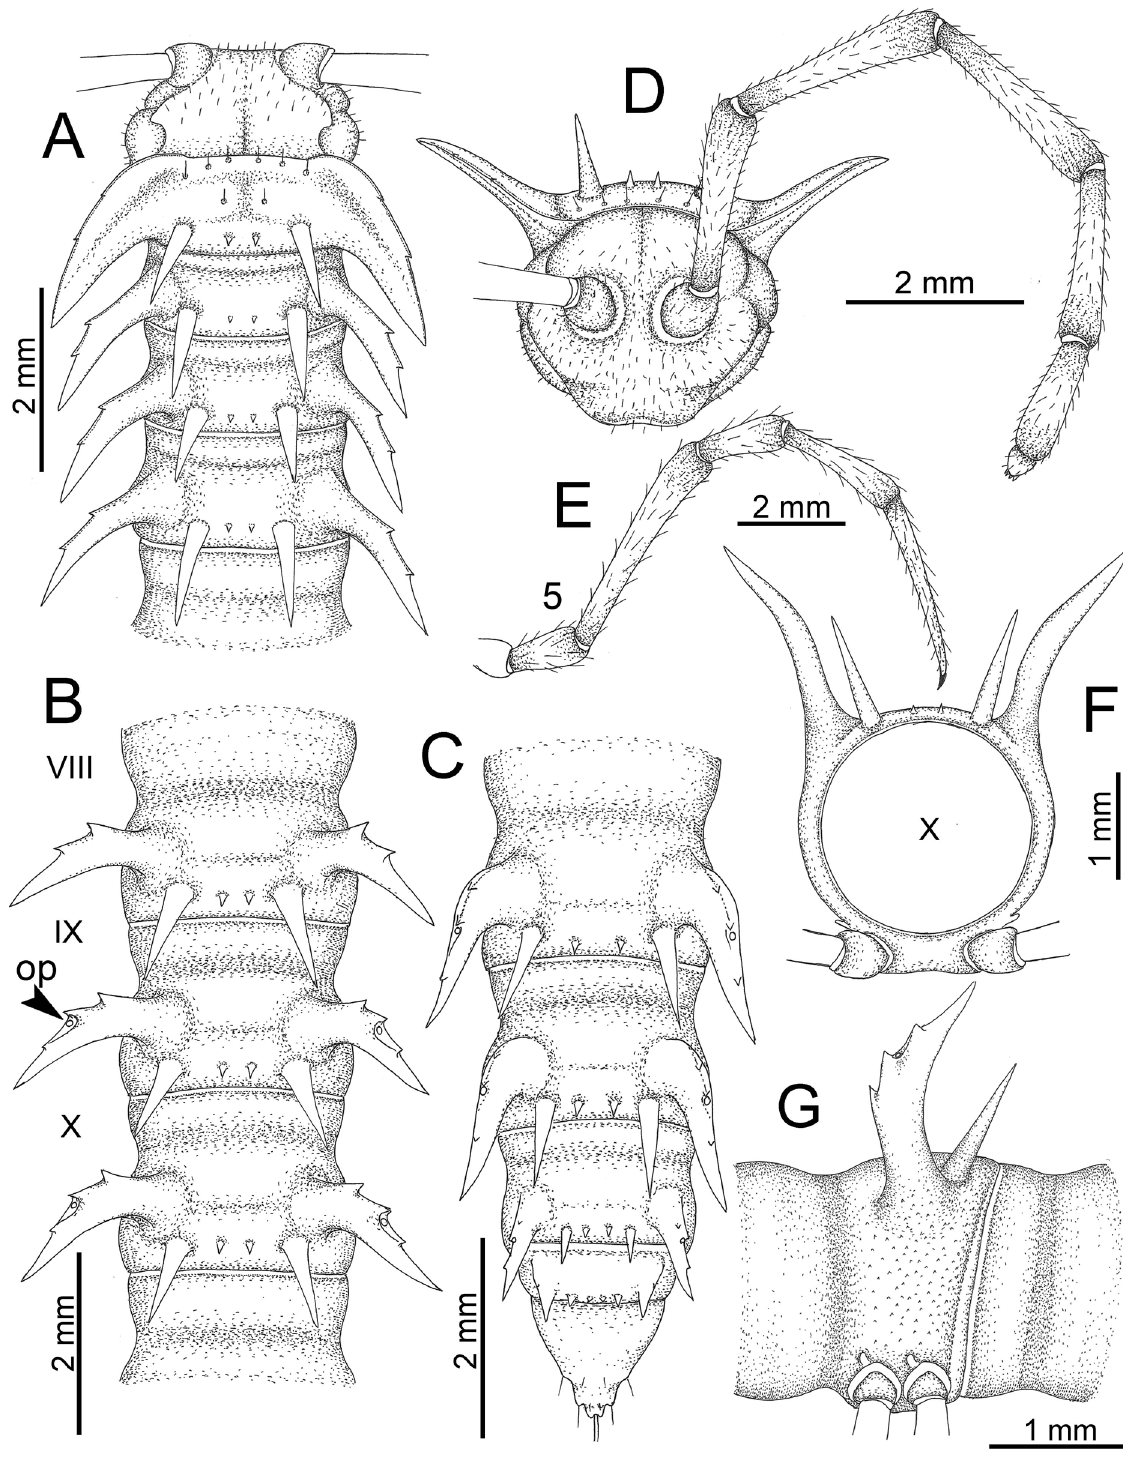
Fig. 7. Nagaxytes acantherpestes (Golovatch & Enghoff, 1994) gen. et comb. nov., ♂, holotype (ZMUC 000101457). A . Anterior body part. B . Body rings 8–10. C . Posteriormost body rings and telson. D . Head and antenna. E . ♂ leg 5 (right). F – G . Midbody